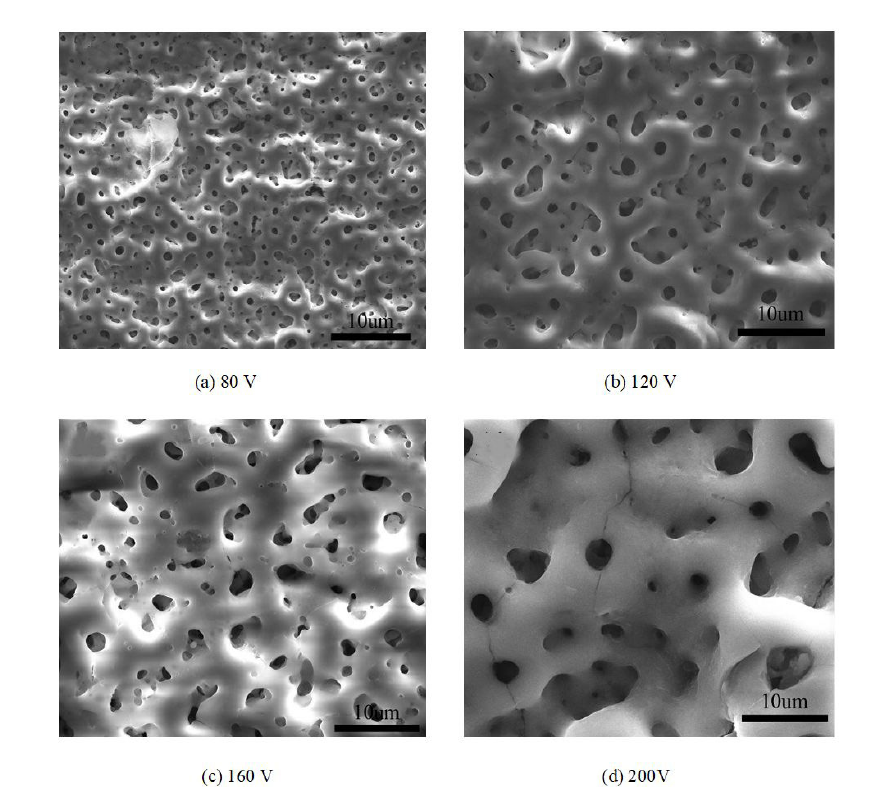
Figure 4. SEM of the MAO coating surface at several voltages: (a) 80 V, (b) 120 V, (c) 160 V, (d) 200